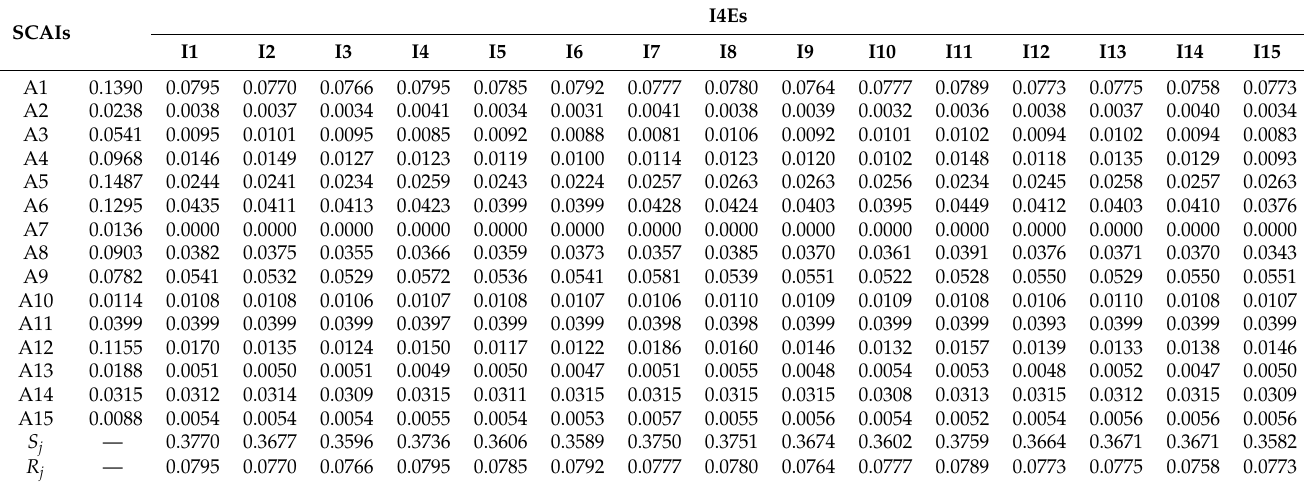
Table A7. Results of group utility S j and individual regret R j .